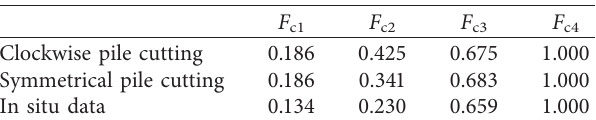
Figure 19: Influence of the pile cutting process on the structural pillar’s axial force. Table 3: Influence of different pile cutting sequences on the structural pillar’s axial